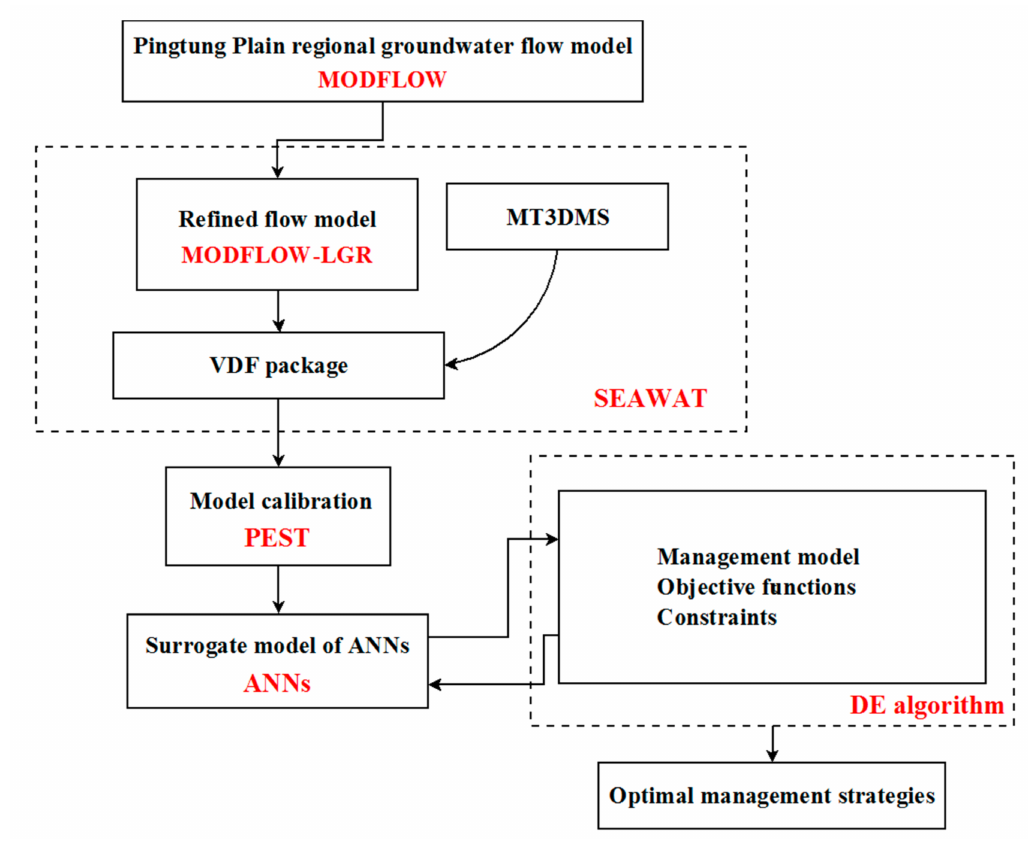
Figure 1. Flowchart of solving simulation–optimization